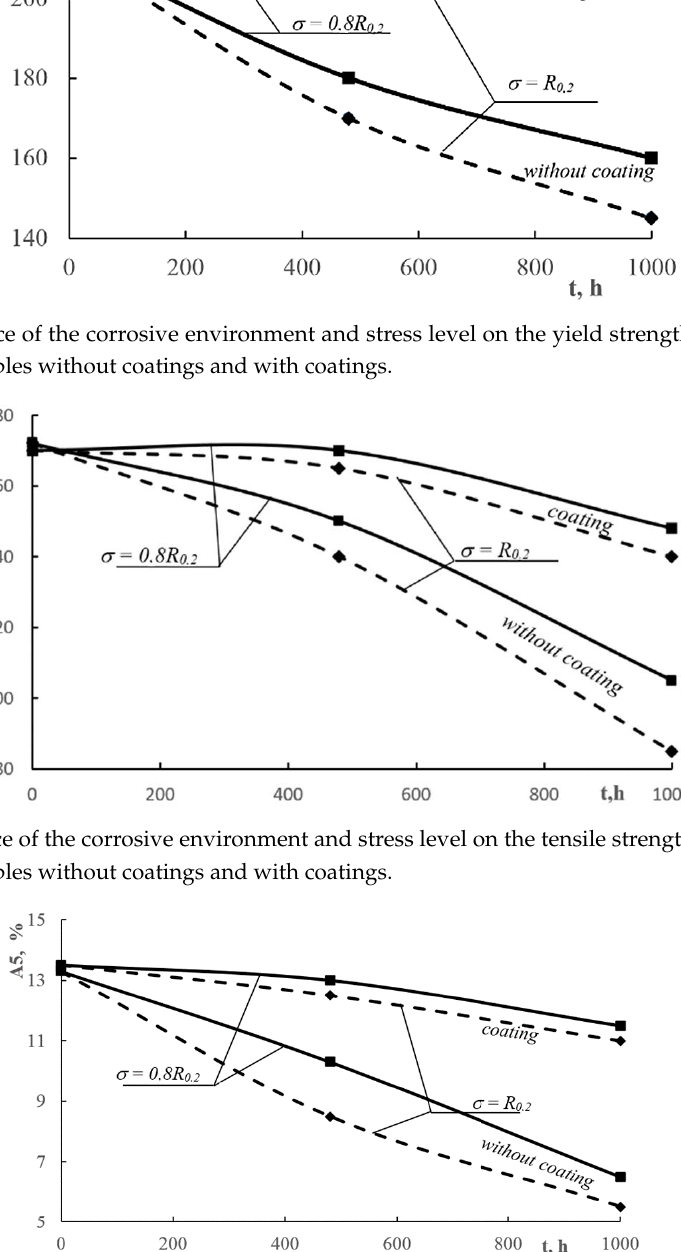
Figure 10 Figure 10. Influence of the corrosive environment and stress level on the relative elongation reduction of AlMg6 alloy samples without coatings and with